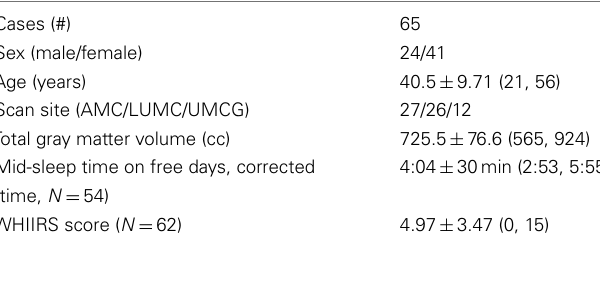
Table 1 | Participant characteristics [numbers, ratios, and mean ± standard deviation